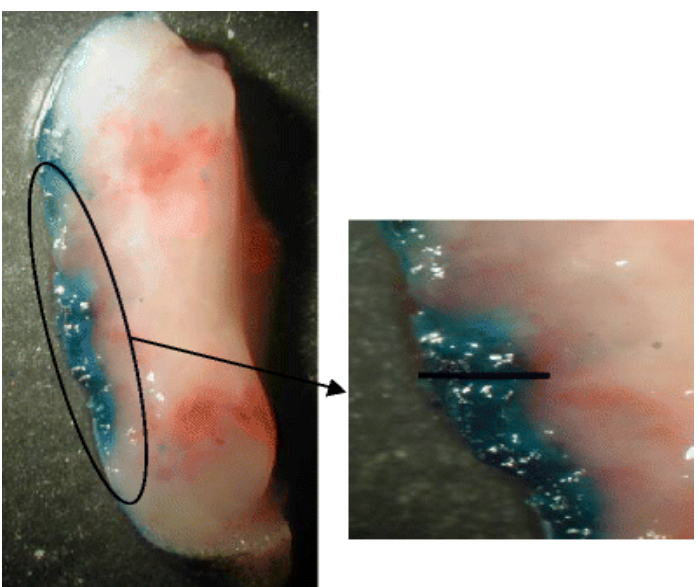
Figure 6. Delivery of methylene blue into the tumor from Tumorep. Photomicrographs showing delivery into the tumor of methylene blue following 4 h of application of Tumorep gel containing 1% methylene blue (bar = 1 mm). Efficient delivery of the colored probe into the tumor after 4 h is shown (Reproduced from reference [16] with permission).